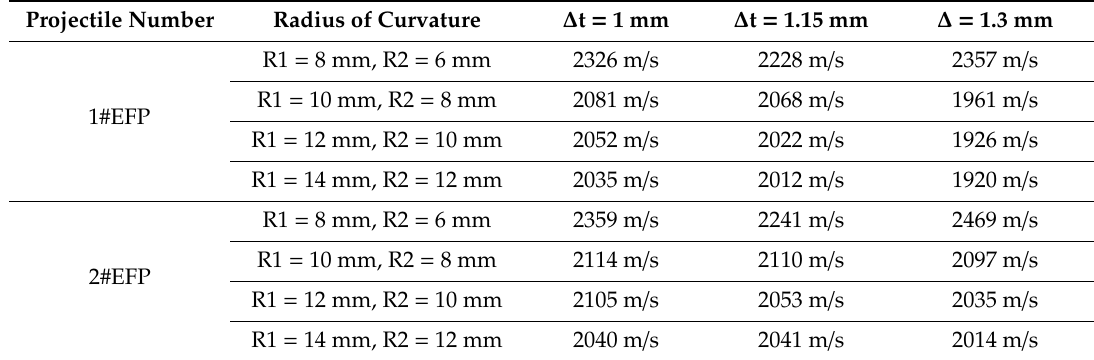
Table 5. 1#EFP-4#EFP formed velocity.